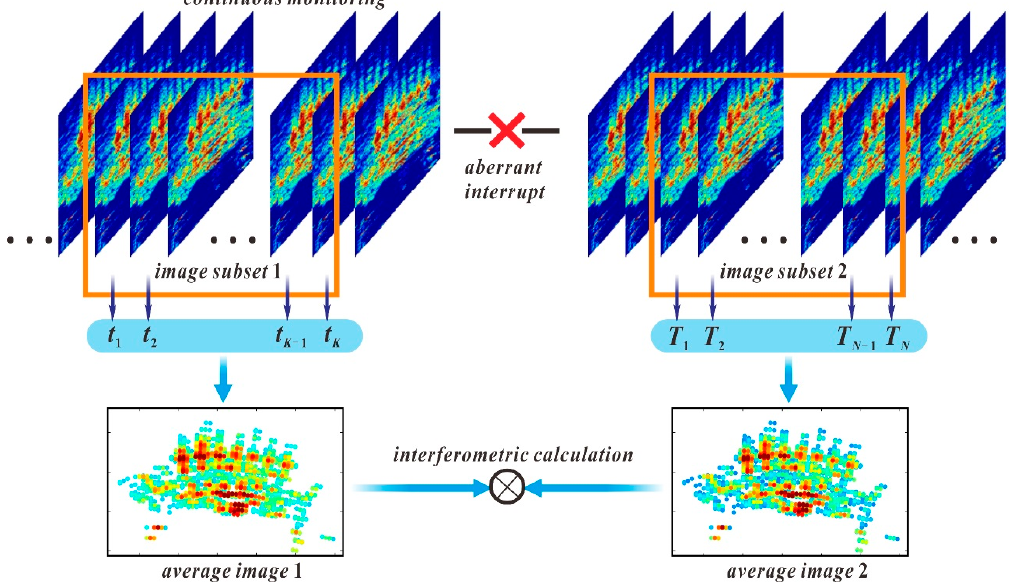
Figure 1. Conceptual framework of differential ground-based synthetic aperture radar interferometry (GB-InSAR) calculation using image subsets.